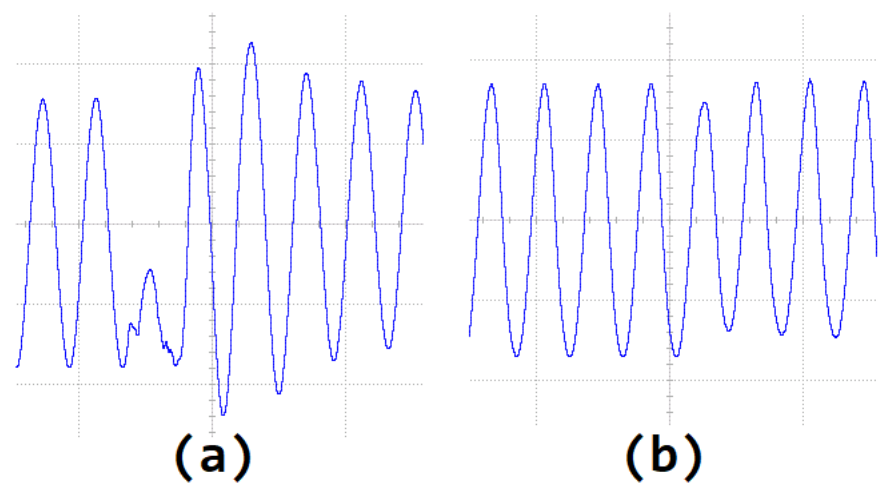
Figure 9. Connection ( a ) and removal ( b ) of the